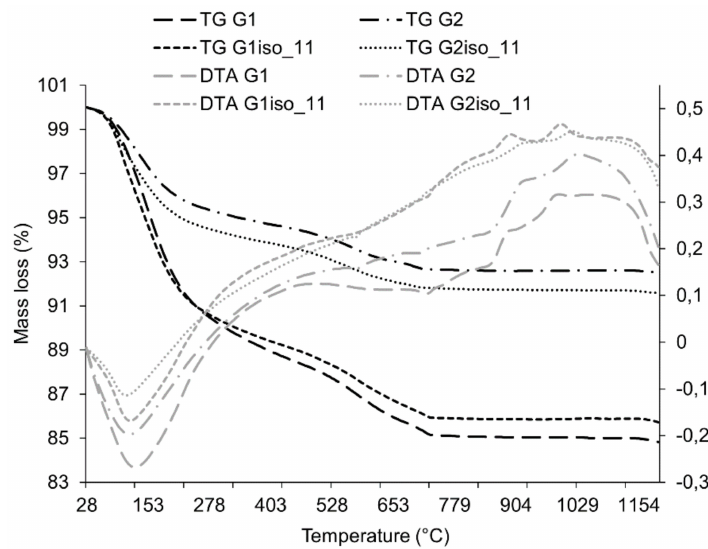
Figure 11. TG-DTA curves of the geopolymeric matrices G1 and